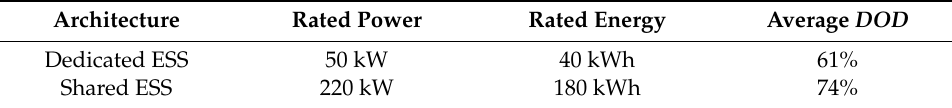
Table 4. Sizing of dedicated I-Life ESS for CSs by using di ff erent battery packs.